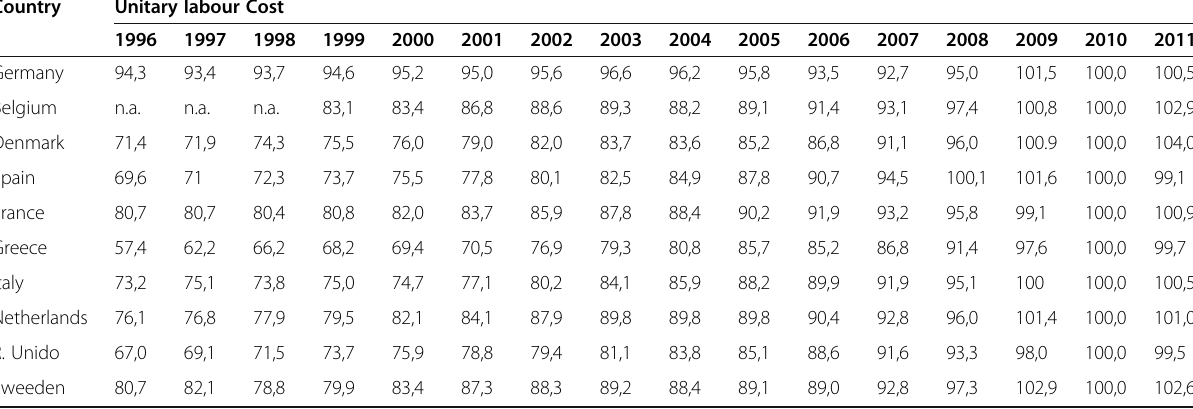
Table 5 Unitary Labour Cost in selected EU countries, 1996 – 2011 (2010 =